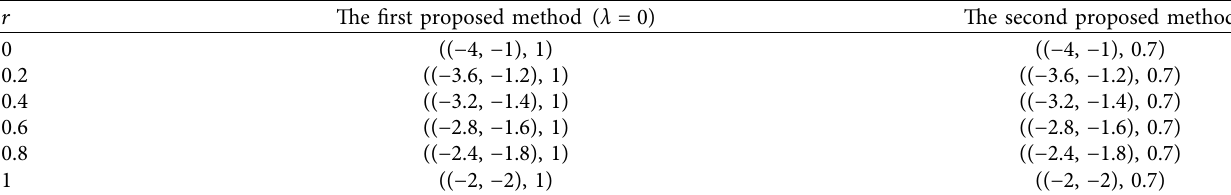
( r ) result using the two proposed methods ( λ � 0 ) . 1